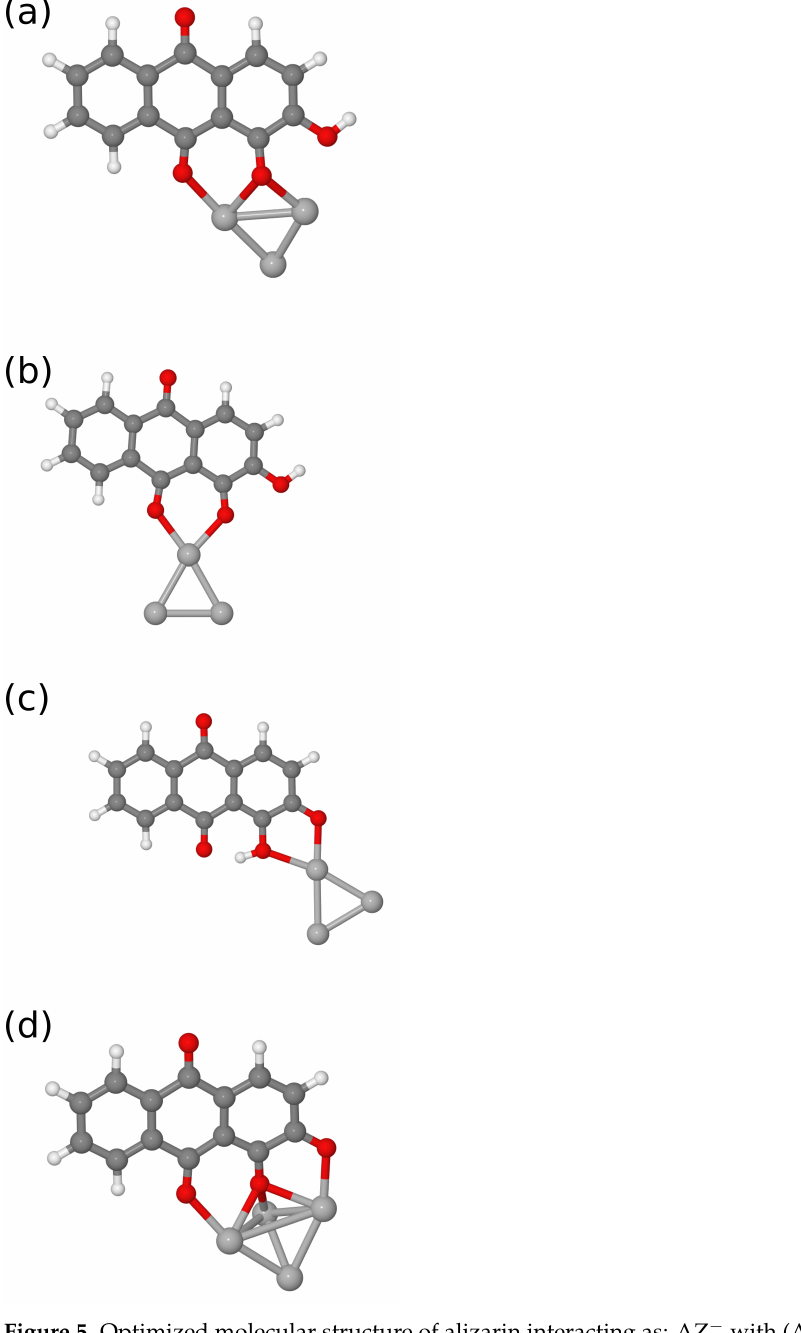
Figure 5. Optimized molecular structure of alizarin interacting as: AZ − with (Ag 3 ) + cluster ( a – c ); and AZ 2 − with (Ag 4 ) 2 + for ( d